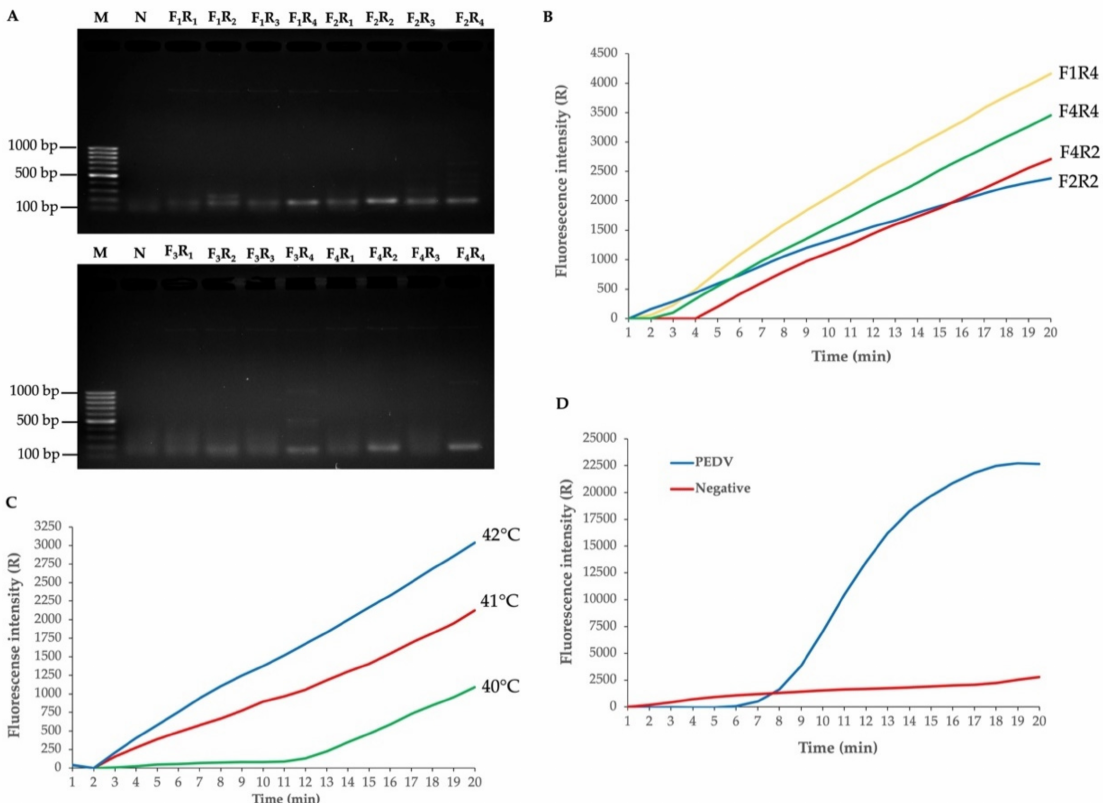
Figure 2. Optimization for M gene of PEDV amplification. ( A ) Screening primer pair for M gene amplification by conventional PCR. M: DNA marker; N: negative, no template; Primer pair: F1R1, F1R2, F1R3, F1R4, F2R1, F2R2, F2R3, F2R4, F3R1, F3R2, F3R3, F3R4, F4R1, F4R2, F4R3, F4R4. ( B ) Am- plification of M gene by RPA. ( C ) Optimization of RPA condition. ( D ) RT-RPA M gene amplification with PEDV RNA template. Negative: the reaction mixture with no